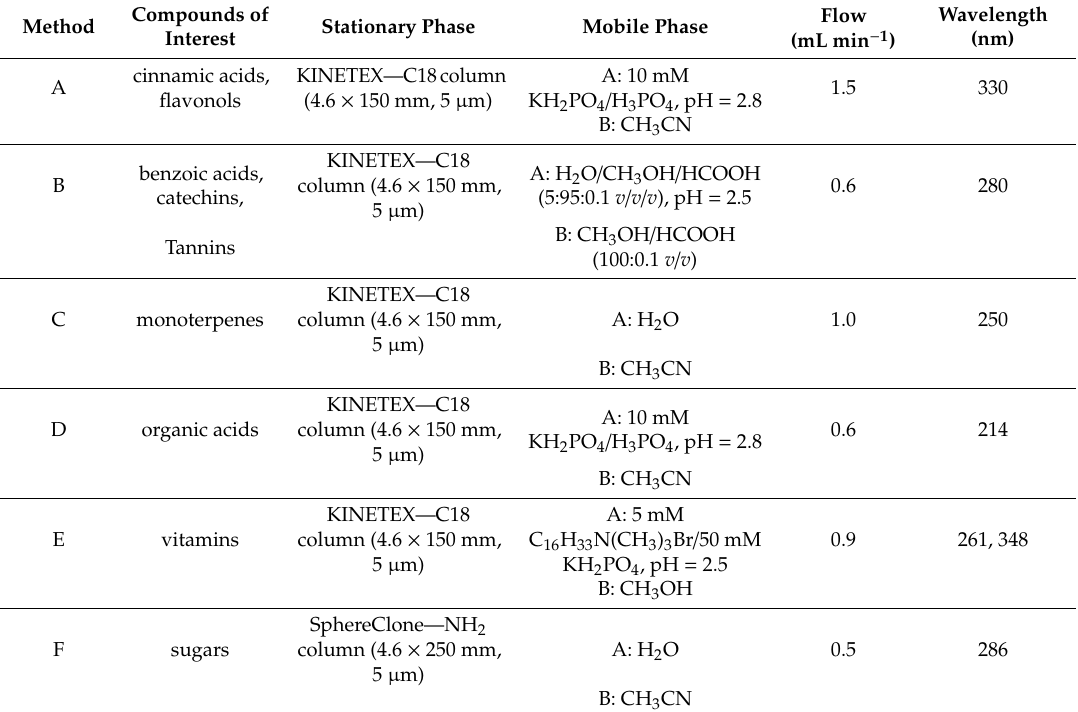
Table 2. Chromatographic conditions of the used